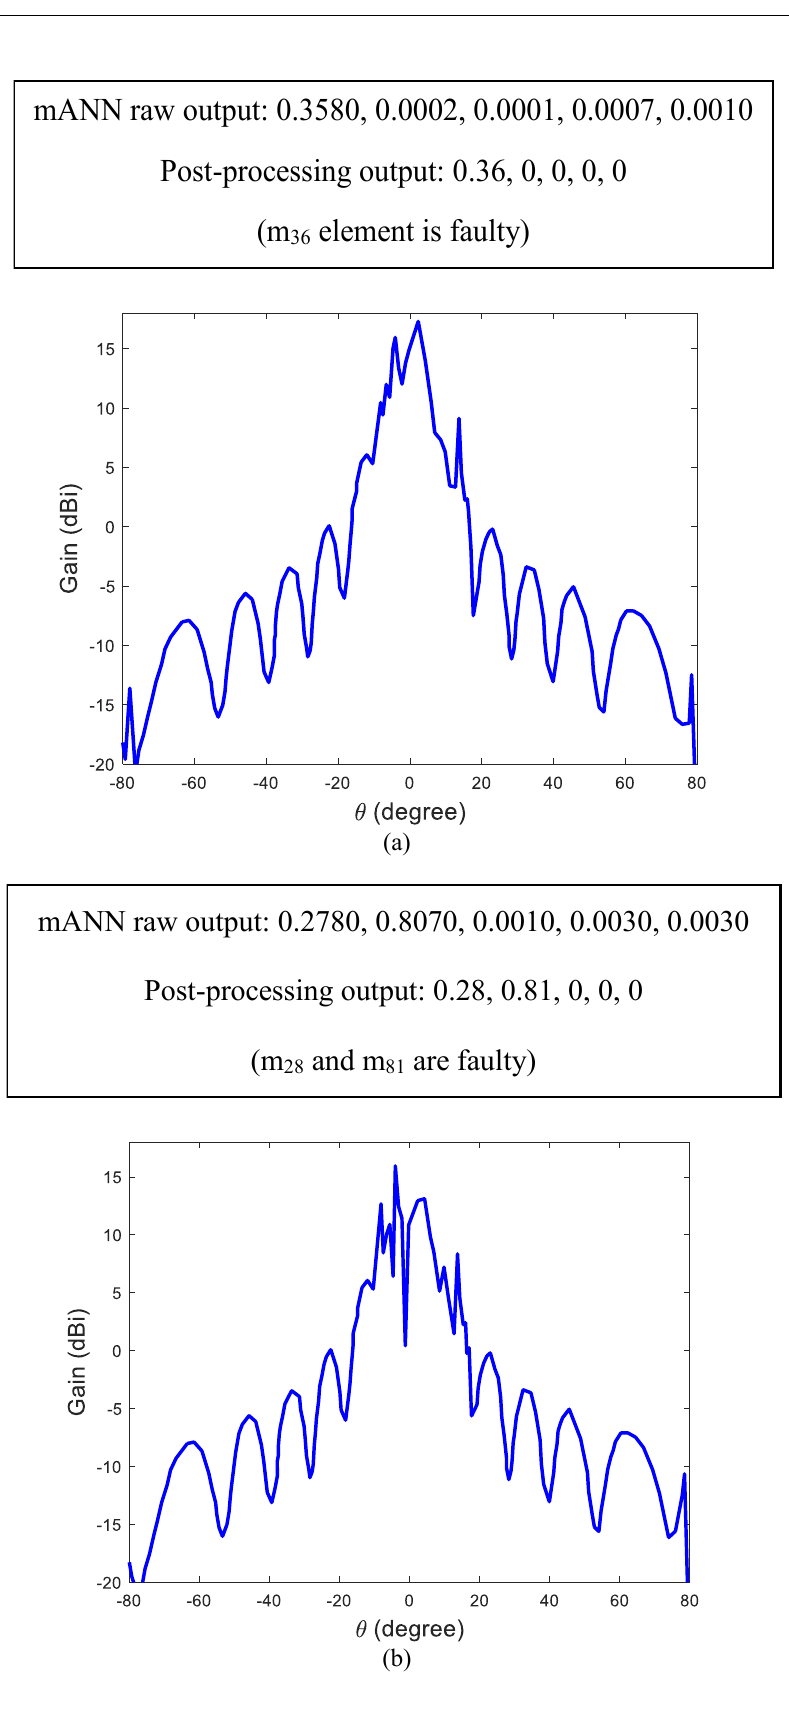
FIGURE. 10 [a, b]. Radiation pattern of fault (s) and corresponding multivalued ANN output in the insets. (a) Radiation pattern with single element ( 𝑚 ’( ) fault (b) Radiation pattern with double elements ( 𝑚 )* ,𝑚 *+ )